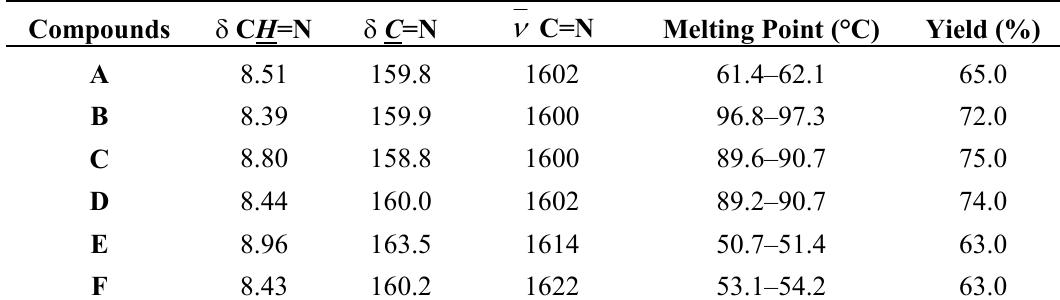
Table 2. Spectral data of aza-stilbene